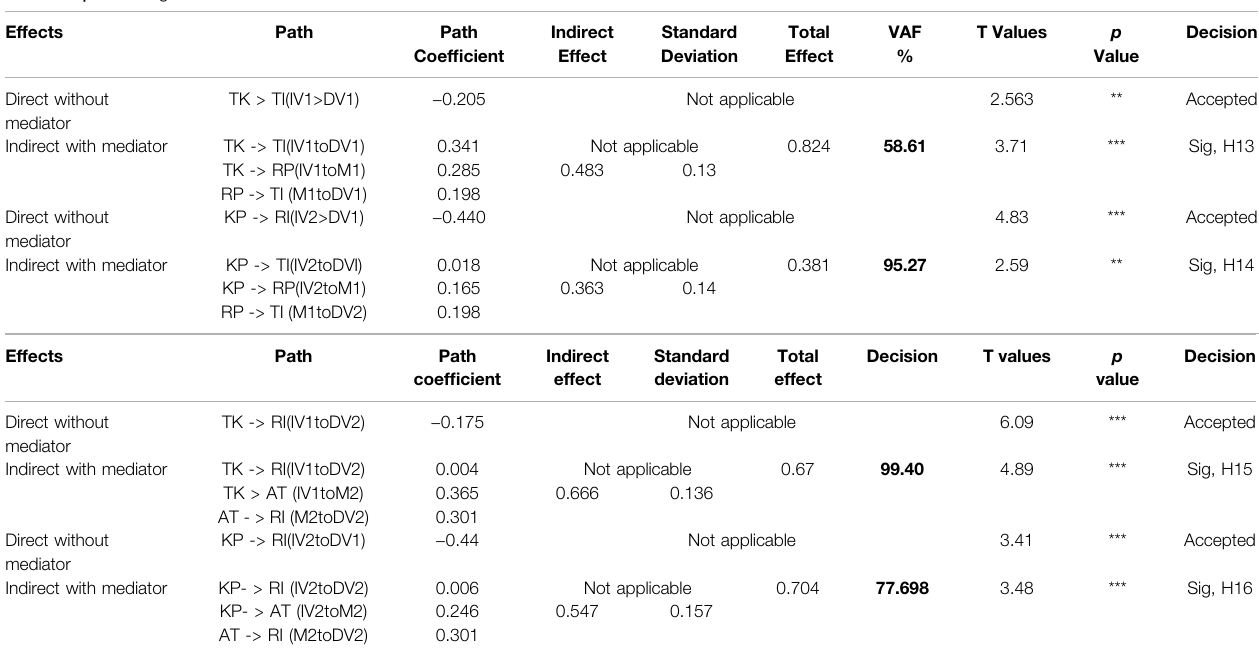
TABLE 7 | Examining